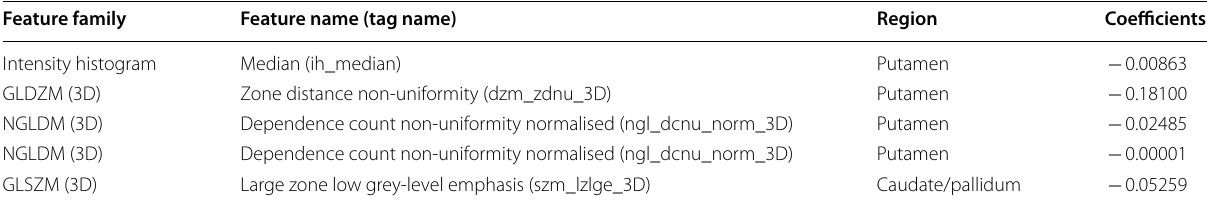
GLDZM grey-level distance zone matrix, NGLDM neighbourhood grey-level dependence matrix, GL SZM grey-level size zone matrix